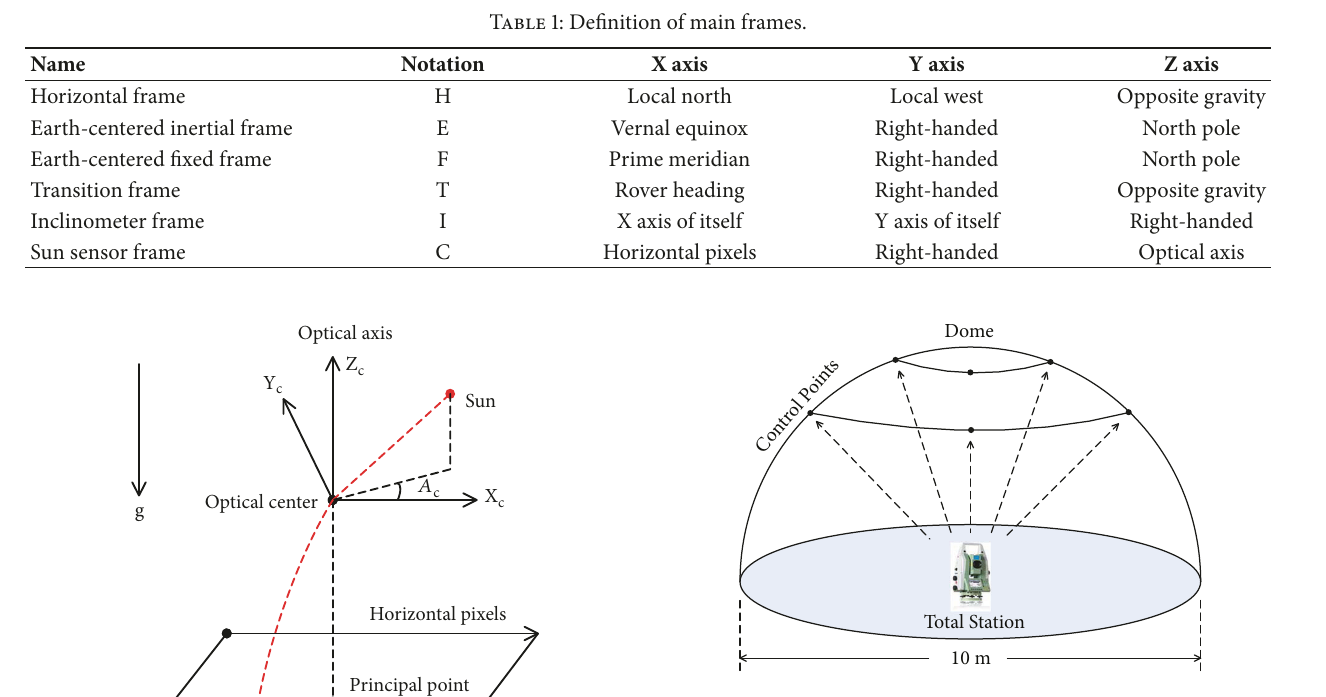
Figure 3: 10-m diameter dome and measurement sketch of control points.